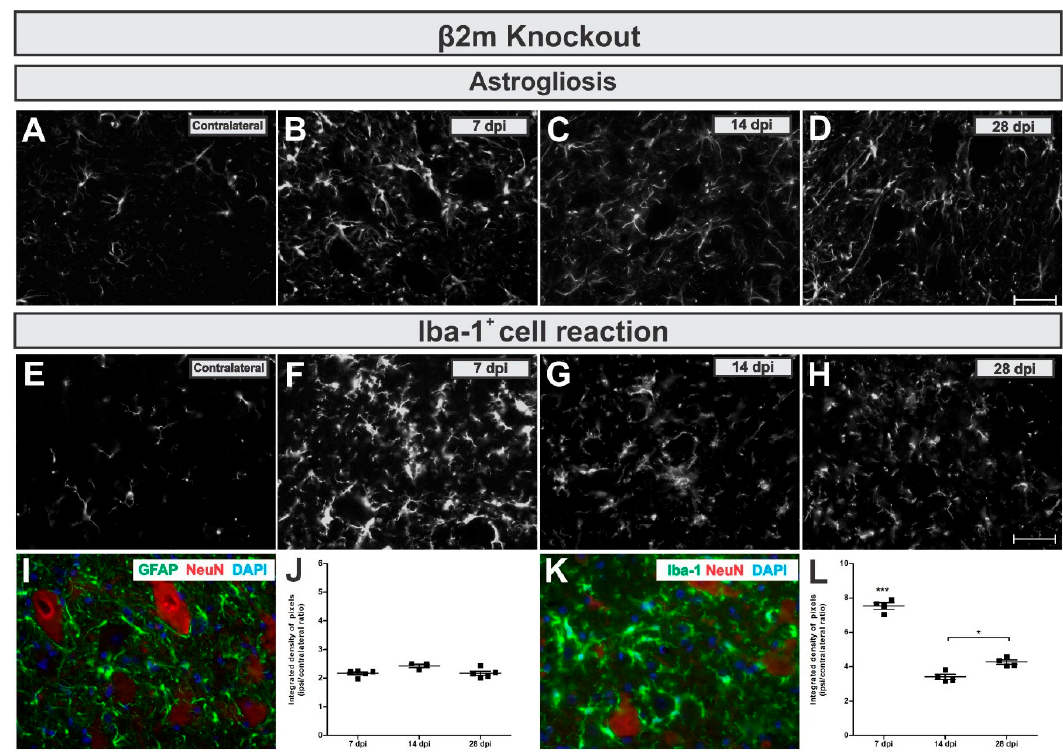
Figure 7. Time-course of astrogliosis ( A to D and I ) and Iba-1 + cell reaction ( E to H and L ) in the lumbar spinal cord contralateral side and 7, 14 and 28 dpi post ventral root injury in β 2m knockout mice is kept constant over time and microglial reaction is more intense in the acute phase after injury. I and K illustrate the glial reaction in the ipsilateral side nearby axotomized motoneuron-like cells, positive to NeuN (in red). ( J and L ) show the comparative quantification among time points post injury (ipsi / contralateral ratio); p < 0.05 (*) and p < 0.001 (***). Scale bar = 50 µ m. Description of the calculated IL / CL integrated density of pixels ratio mean ± standard error from Iba-1 immunoreactivity in 7dpi in β 2m KO groups: 7 dpi = 7.53 ± 0.2; 14 dpi = 3.40 ± 0.2; 28 dpi = 4.16 ± 0.2. In β 2m KO mice, the analysis of the anti-synaptophysin immunolabeling around lesioned motoneuron-like cells showed that the synaptic coverage was reduced by 48% at day 7 after lesion, reaching 56% reduction at day 28 (Figure 8). When statistically compared, the synaptic coverage was 29% lower 28 days after VRC when compared to 7 dpi ( p = 0.0013, F 2,10 = 13.87, Bonferroni post-test). IL / CL integrated density of pixels ratio means ± standard errors from synaptophysin immunoreactivity β 2m KO groups led to the following data: 7 dpi = 0.62 ± 0.05; 14 dpi = 0.47 ± 0.03; 28 dpi = 0.44 ±